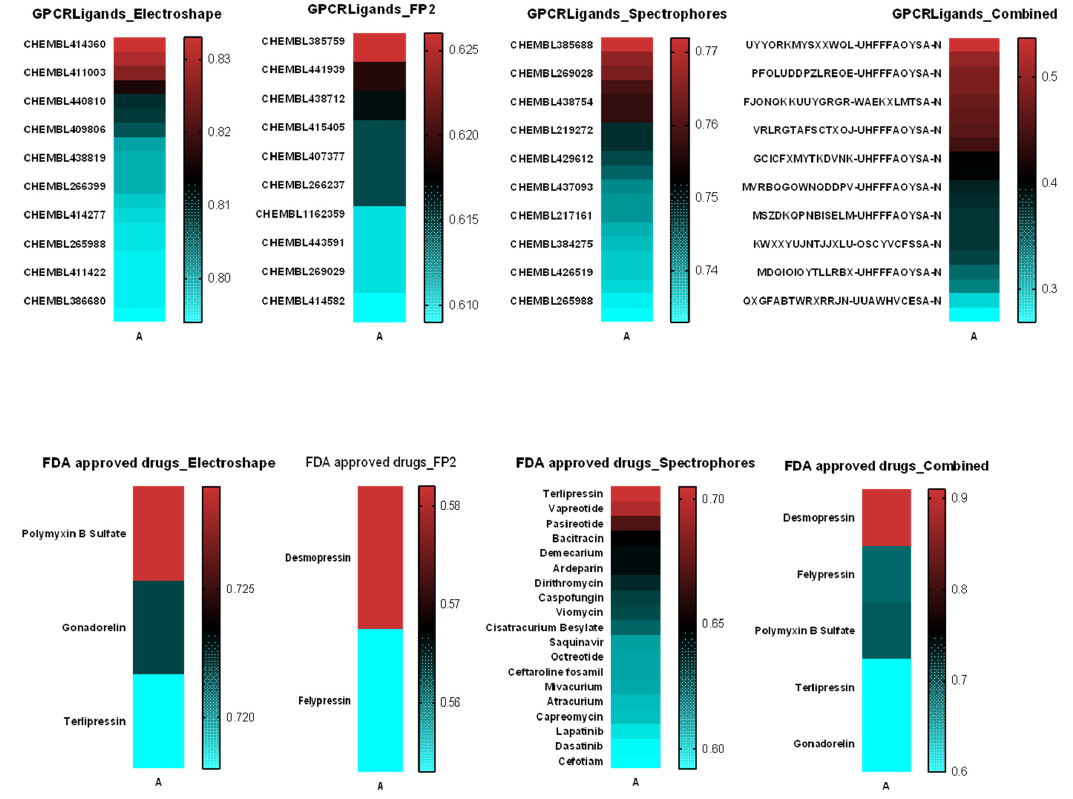
Figure 5. Similarity of Tn P. We applied SWISS-MODEL homology modeling tool enhanced by ChEMBL databases and ElectroShape virtual screening method that combines shape and electrostatic information to identify potential drug candidates that can interact with the protein of interest.